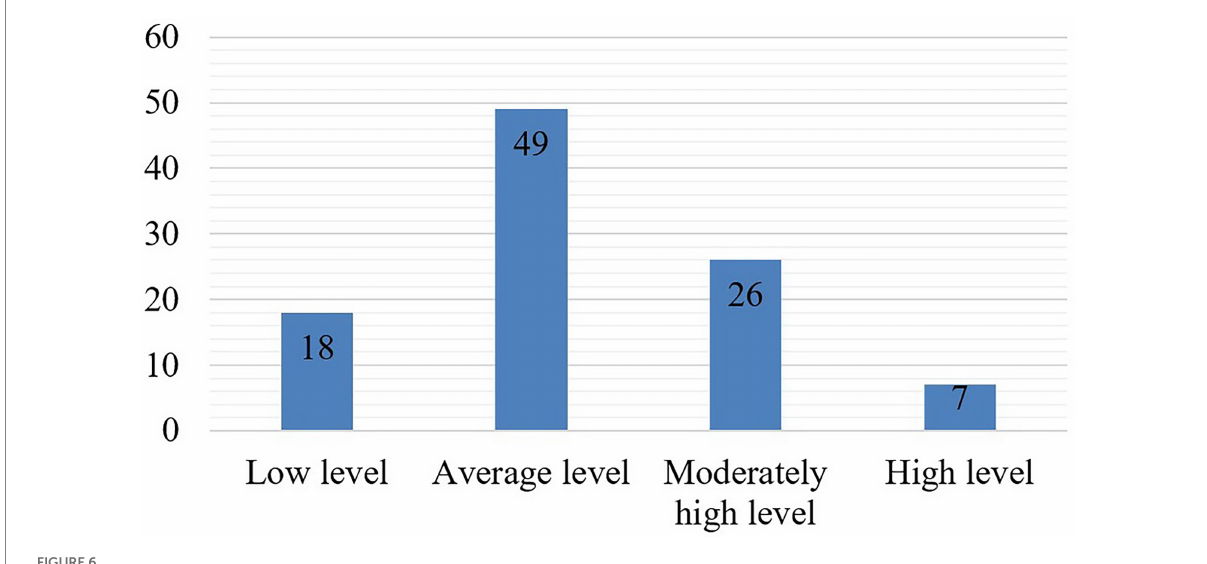
FIGURE 6 Motivation levels in achieving career